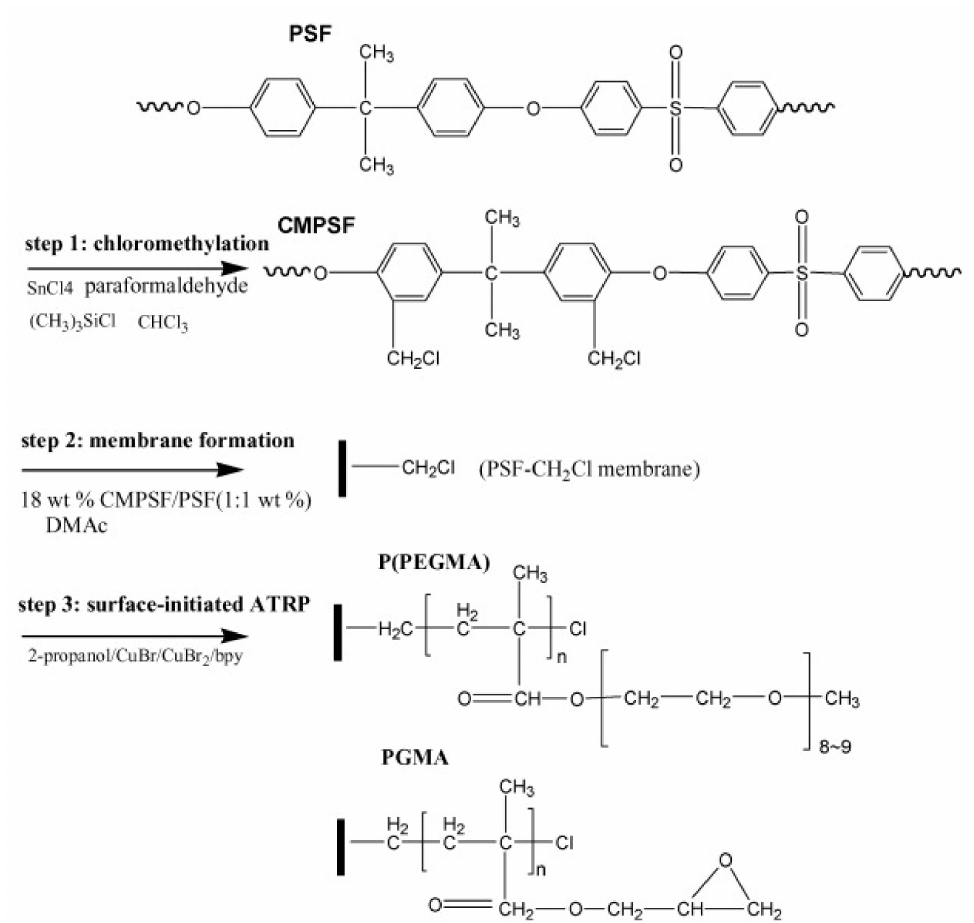
Figure 5. Process of surface-initiated ATRP from the polysulfone membrane (reproduced with permission after